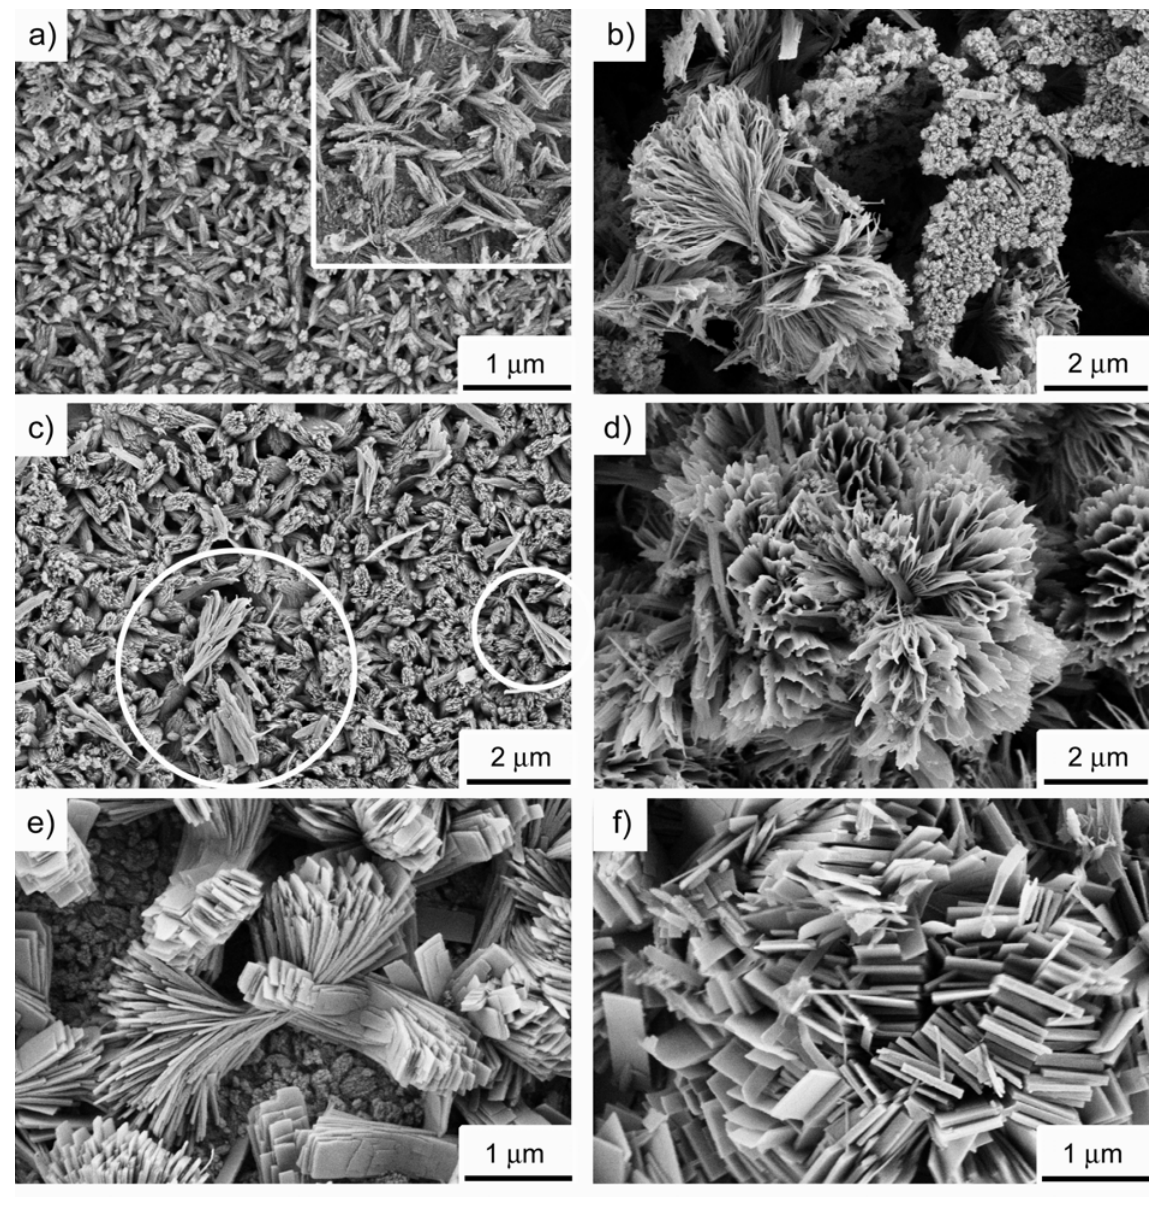
Figure 9 . SEM of samples isolated after different reaction times. (a) 10 hours, (b) 16 hours, (c, d) 26 hours, (e) 20 hours, (f) 30 hours. Inset in (a) is a magnified view of the “ellipsoidal” first generation particles, which are made up of threadlike primary building blocks. The circles in (c) highlight a first generation of threads that start to form a wedge (see text for